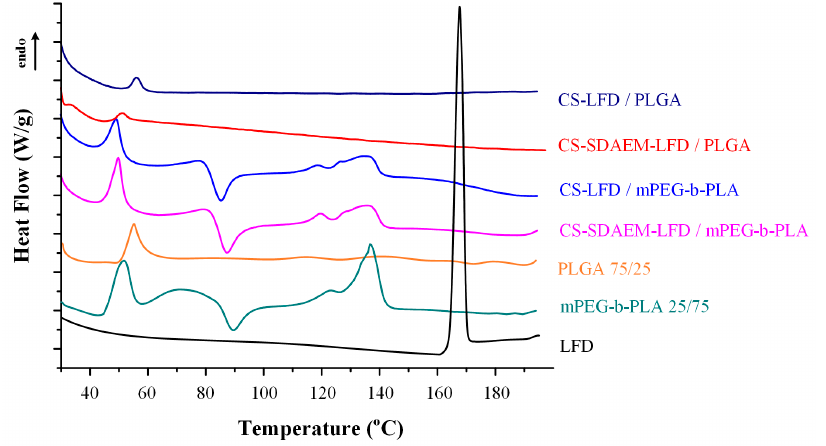
Figure 9. DSC thermogram of mPEG-b-PLA and PLGA thin-films with LFD-loaded NPs.